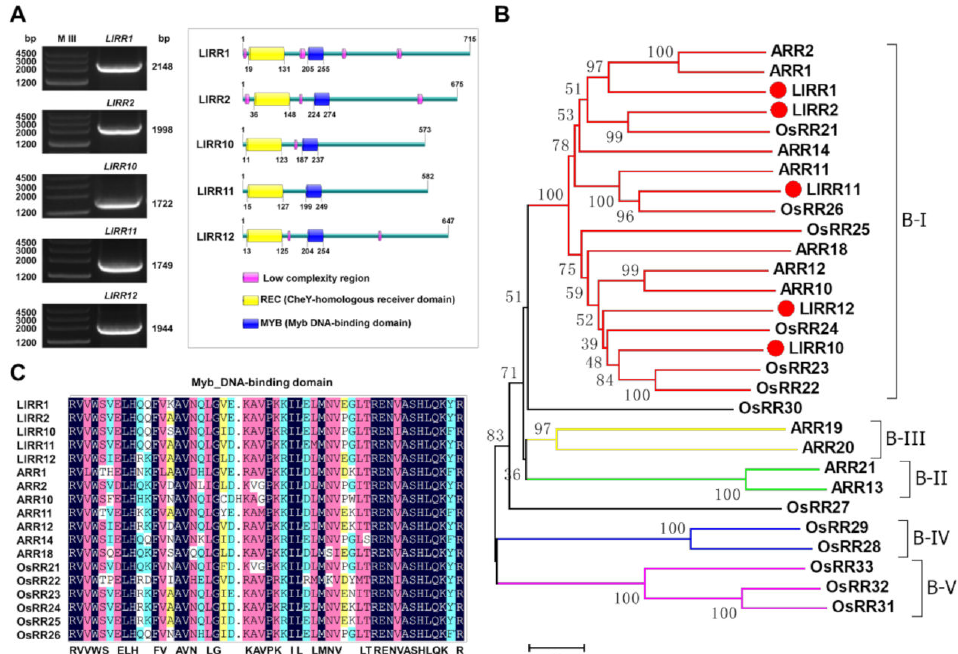
Figure 1. Full-length cloning and bioinformatic analyses of type-B LlRRs. ( A ) Full-length amplification and domain analyses. ( B ) Neighbor-joining tree of type-B Arabidopsis response regulator (ARR) amino acid sequences of Lilium lancifolium , Arabidopsis thaliana and Oryza sativa . ( C ) Multiple sequence alignment of the MYB domain in the B-I subfamily. Sequences from L. lancifolium are LlARRs that are designated with a red triangle; sequences from A. thaliana are shown with ARRs; sequences from O. sativa are shown with OsRRs. Bootstrap values from 1000 replicates were used to assess the robustness of the